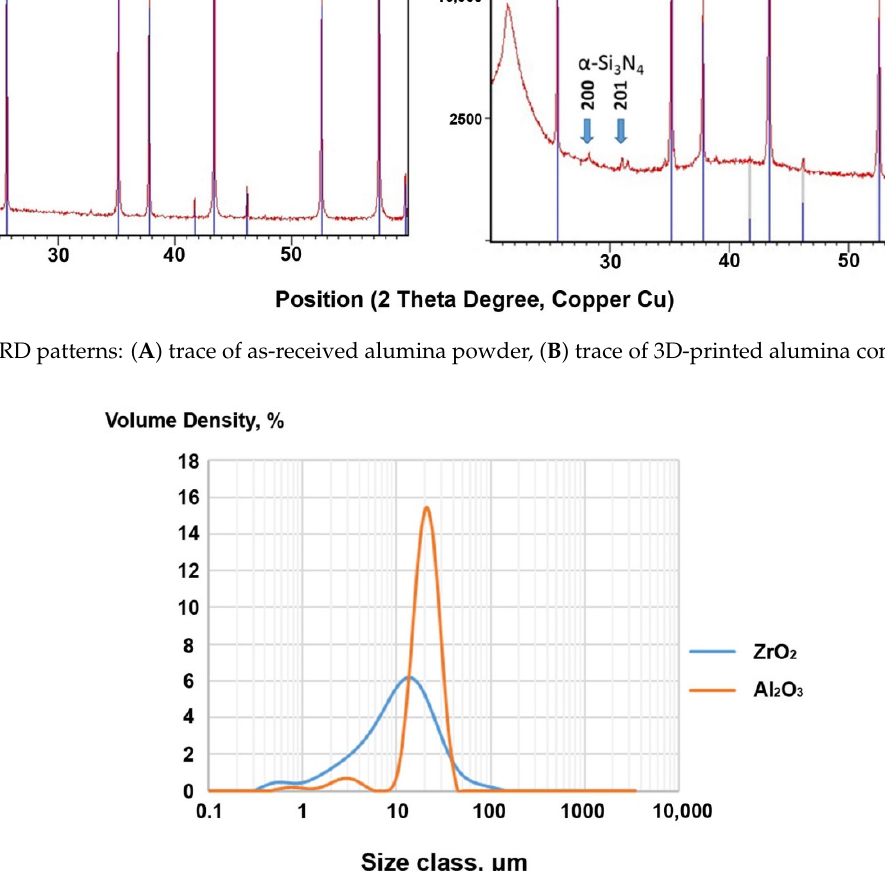
Figure 4. Particle size distribution of the modified ZrO 2 and Al 2 O 3 powders. Table 5. Particle size distribution of the modified ZrO 2 and Al 2 O 3 powders.